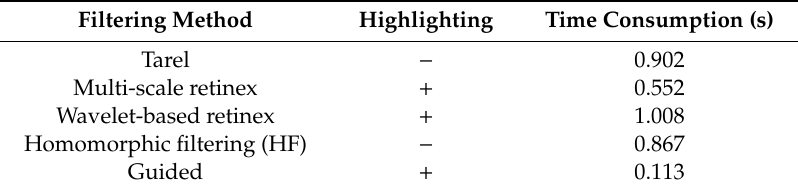
Table 2. Testing data for the di ff erent filtering methods.